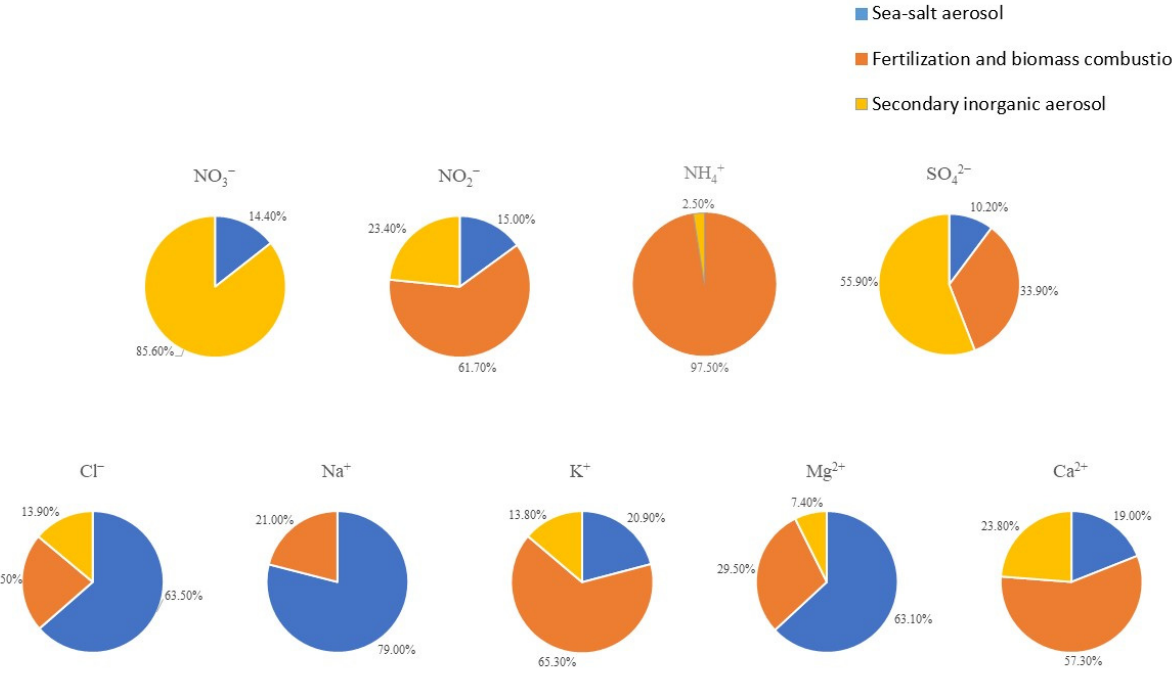
Figure 5. Contribution from different factor as a result of PMF modeling.